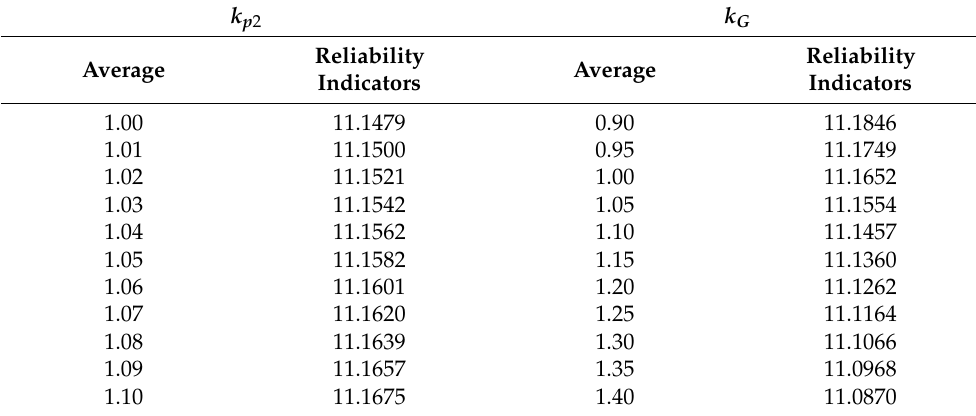
Table 6. Effect of the average value of each parameter on the stability and reliability index under combination